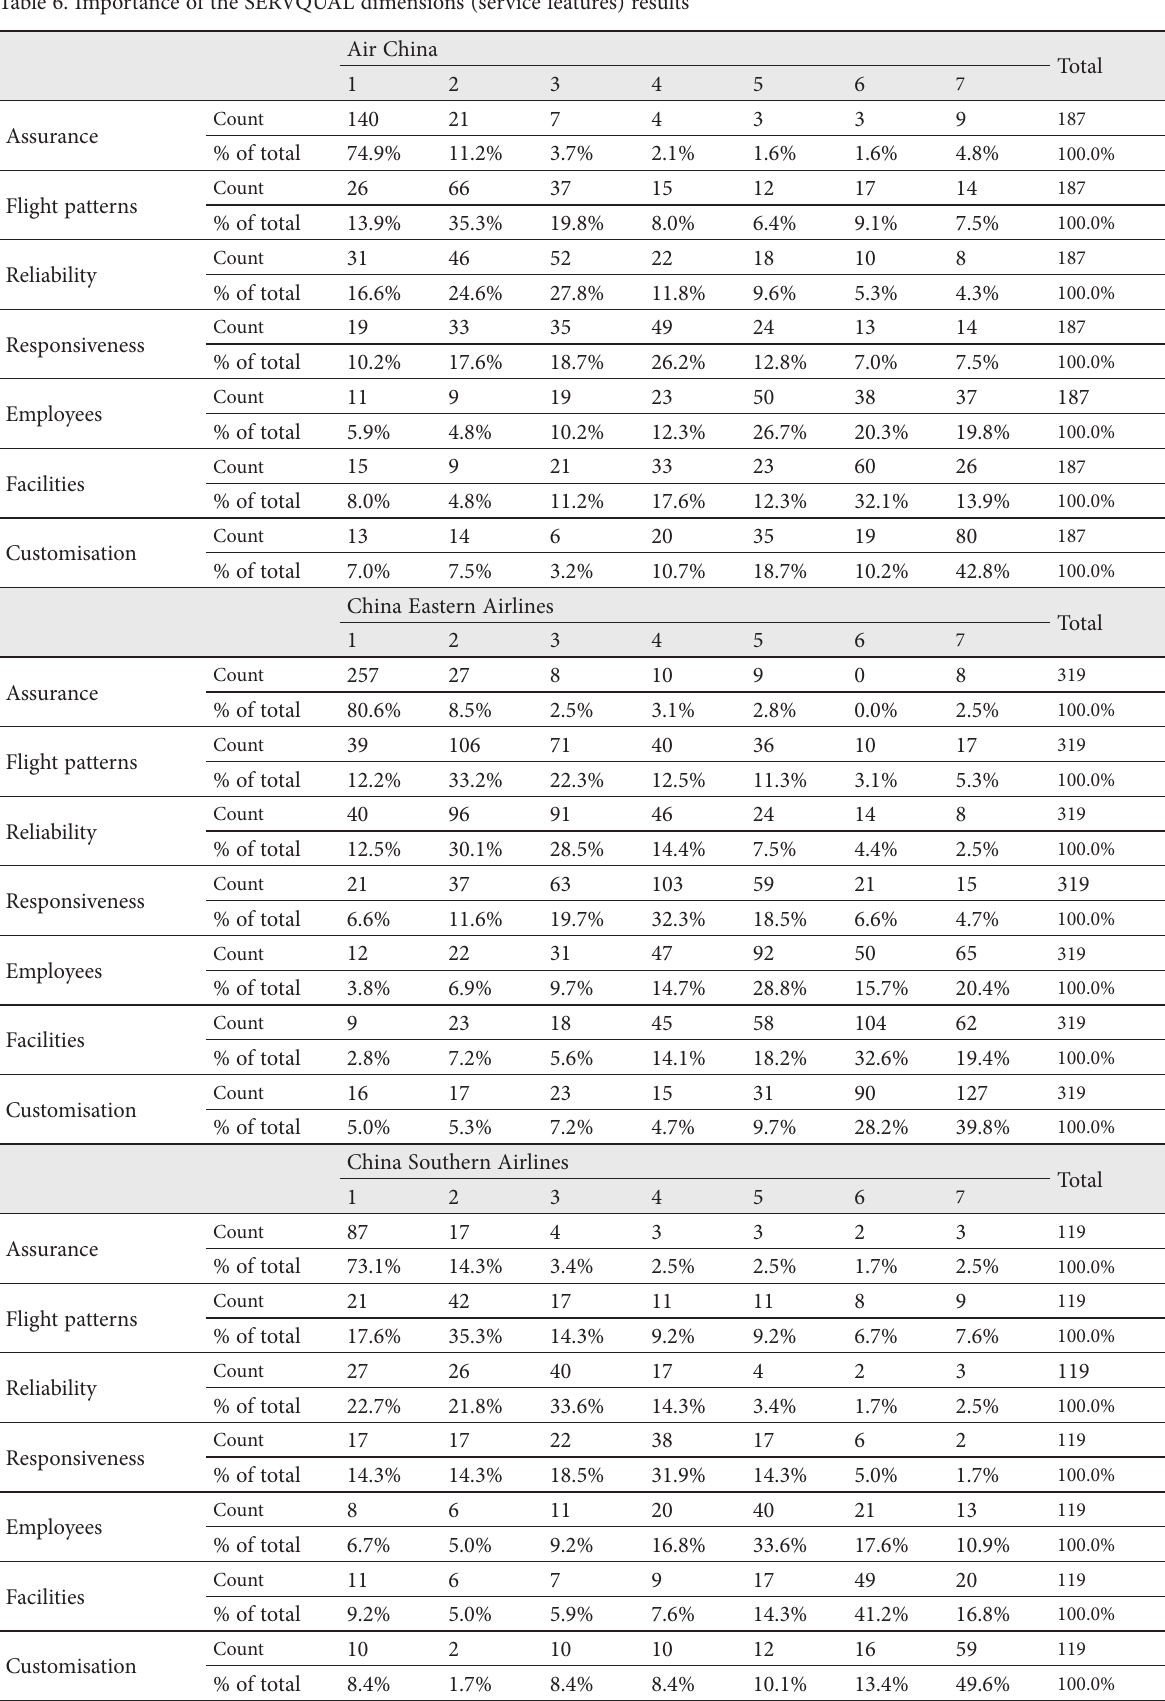
Table 6. Importance of the SERVQUAL dimensions (service features)